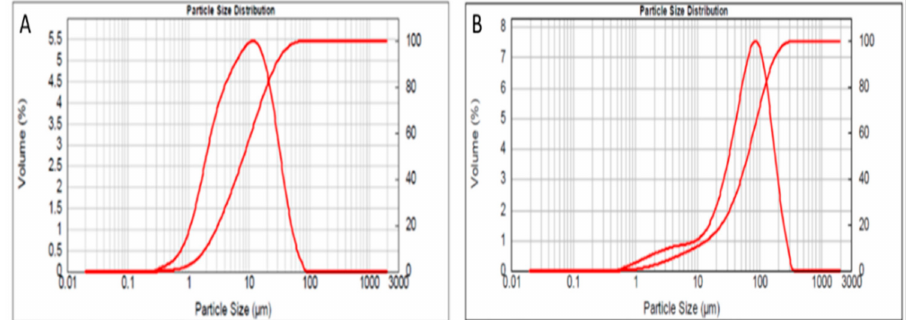
Figure 1. Particle size distribution and cumulative volume for: ( A ) MK and ( B ) WG.